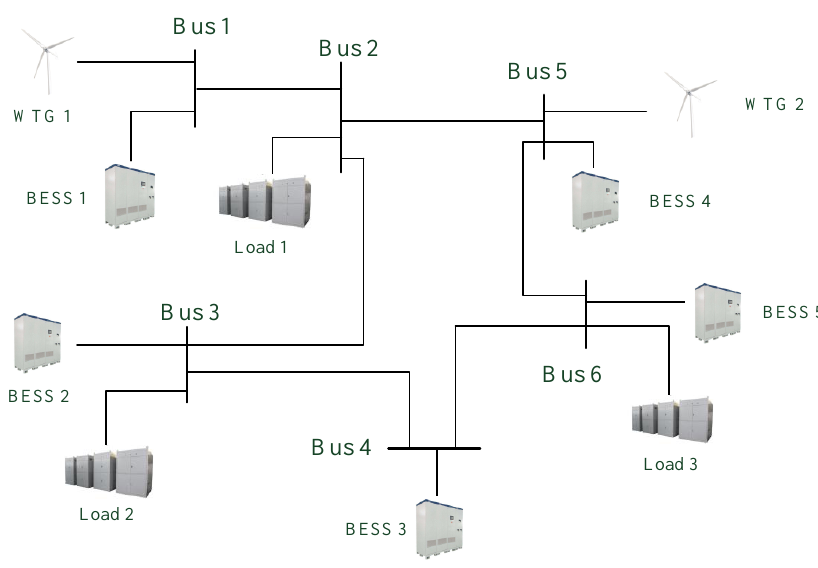
Figure 1. Islanded microgrid